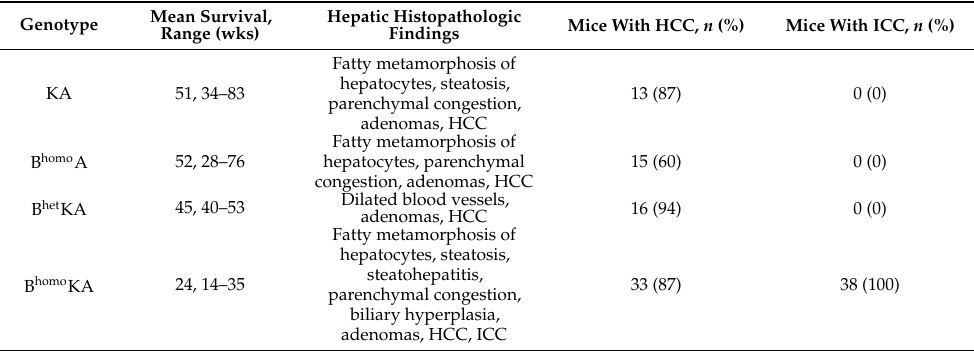
Table 1. Hepatic genotypic and phenotypic differences between GEMM experimental cohorts.